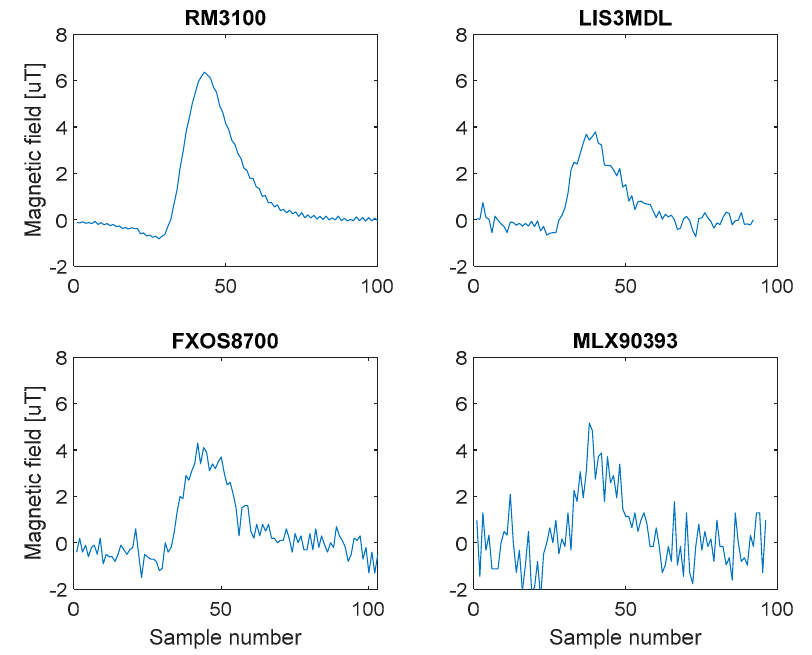
Figure 4. Record of Ford Focus combi in X axis.